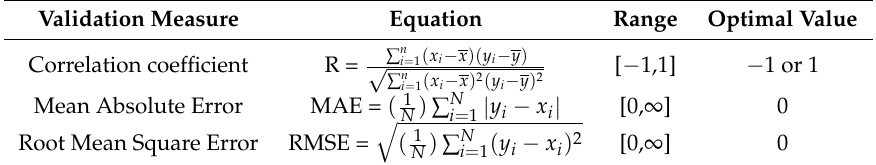
Table 1. Overview of the validation measures used for the validation of the precipitation rates retrieval. y i represents the prediction and x i is the observation. x and y are the mean values of x and y,